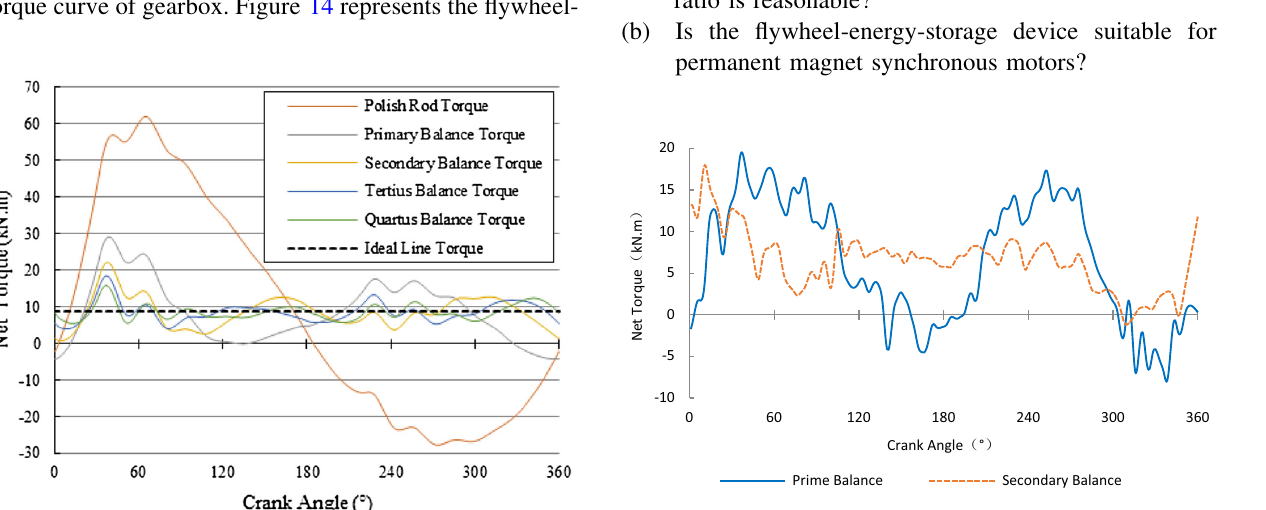
Fig. 13 Net torque curves by prime balance and by secondary balance (Feng et al.